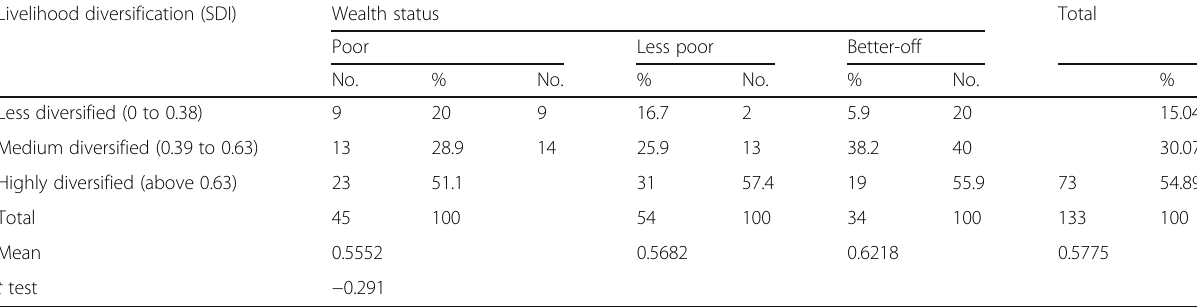
Table 5 Distribution of households with livelihood diversification ( N = 133) Livelihood diversification (SDI) Wealth status Total Poor Less poor Better-off Less diversified (0 to 0.38) Medium diversified (0.39 to 0.63) Highly diversified (above